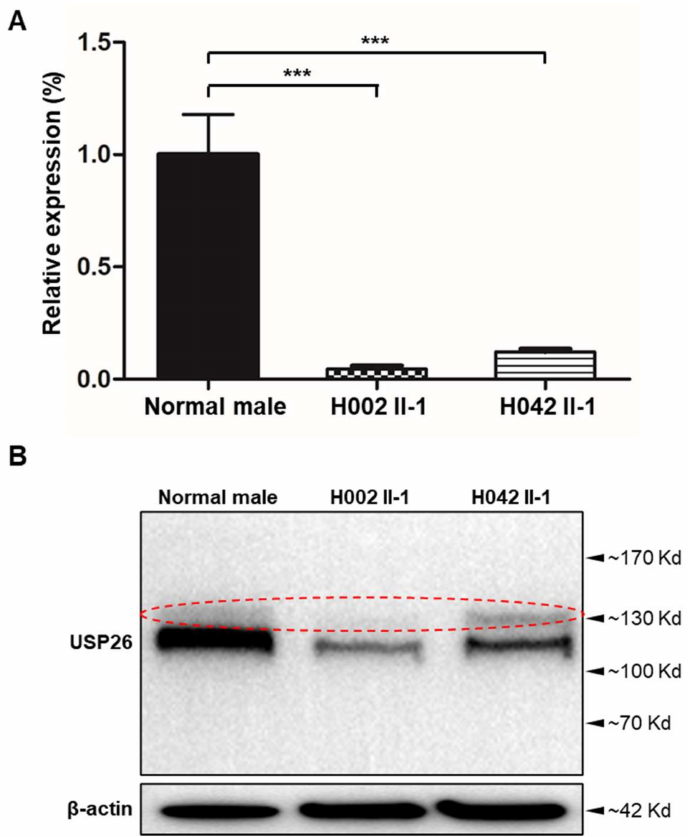
Figure 3. Expression analysis of USP26 mRNA and USP26 in the spermatozoa from a normal male control and men harboring hemizygous USP26 variants. ( A ) Real-time quantitative PCR